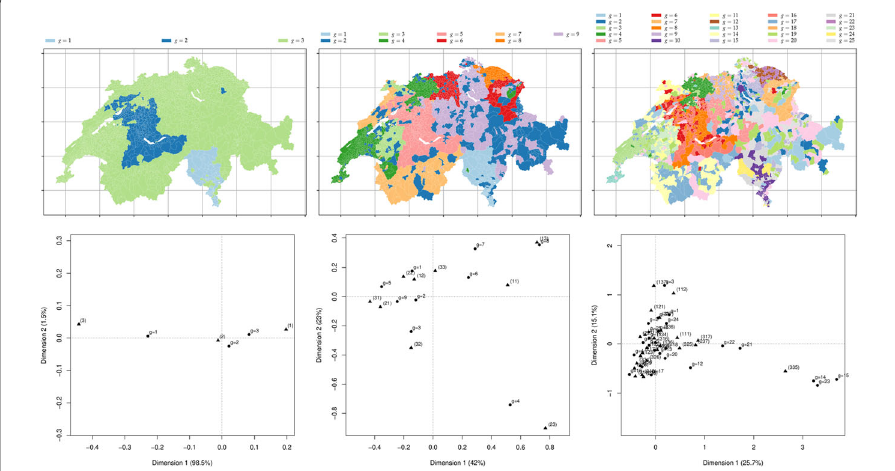
Fig. 14 Top Municipalities assignments from the spectral clustering with the parameters, respectively left-right, m = 3,9,25 for 100 iterations applied on the affinity matrix S (with: r = 1.0, λ = 1.0). Bottom the corresponding CA